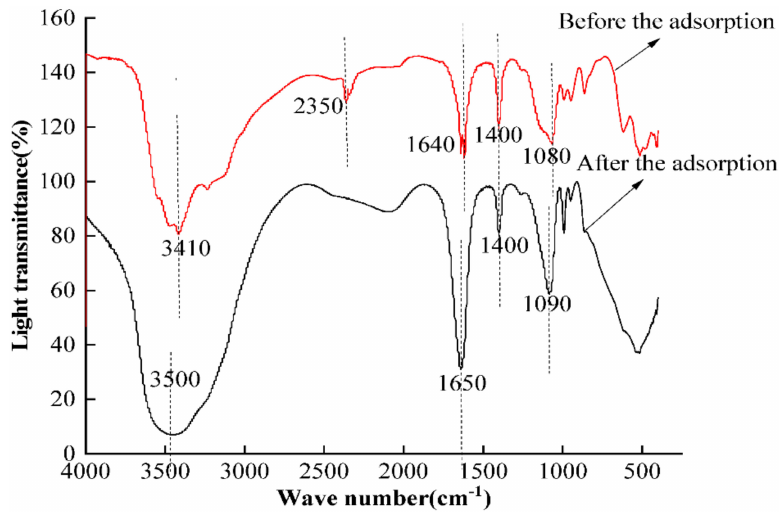
Figure 2. FT–IR spectra of the composite adsorbents before and after